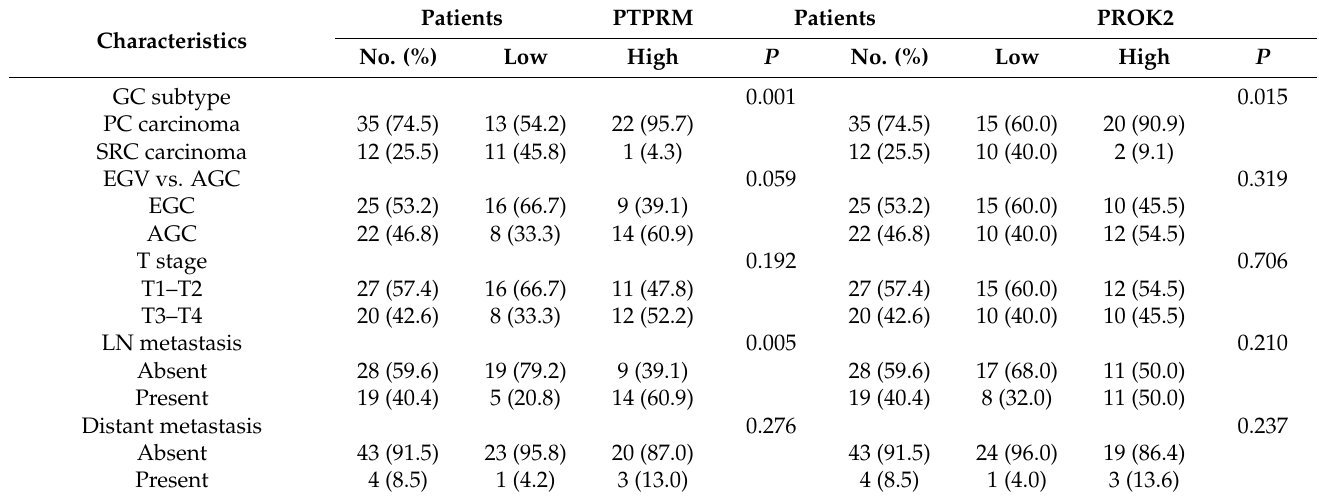
Table 3. Correlation between PTPRM and PROK2 immunohistochemical expression and clinico- pathologic factors in SRC and PC gastric carcinomas ( n =